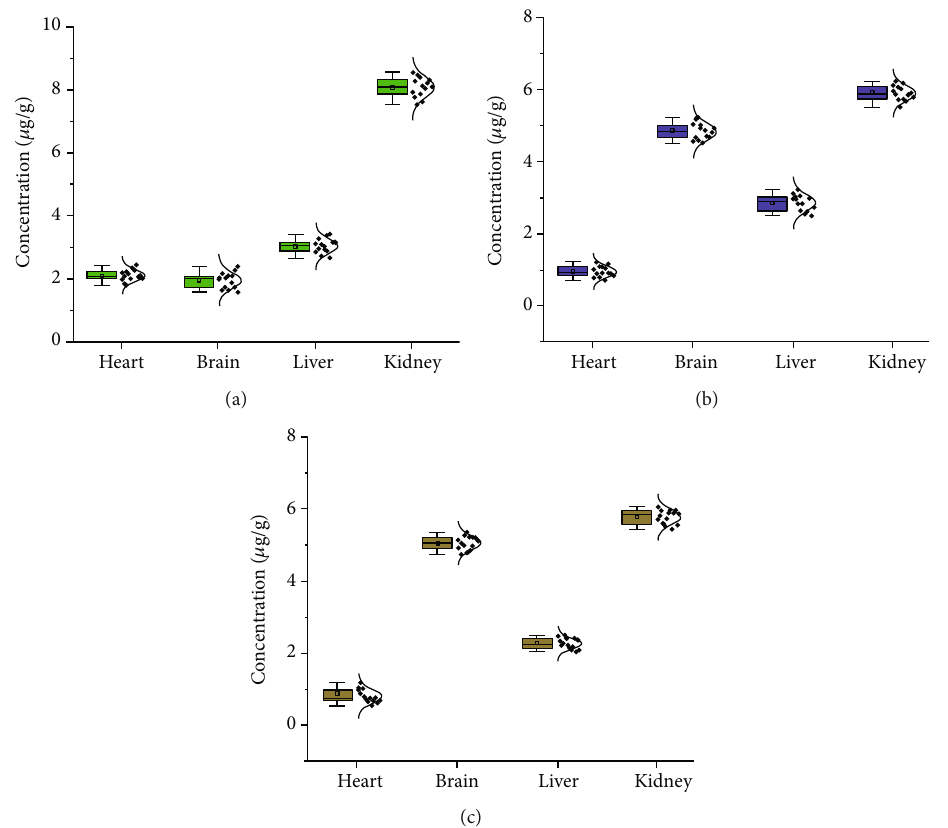
Figure 7: Tissue distribution of di ff erent drugs in mice. (a) DOX. (b) PEG-DSPE/DOX NPs. (c) TF-PEG-DSPE/DOX NPs.